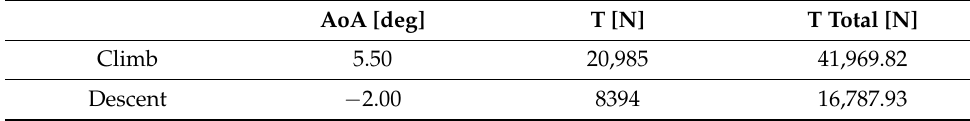
Table 2. Main characteristics—Config. A.